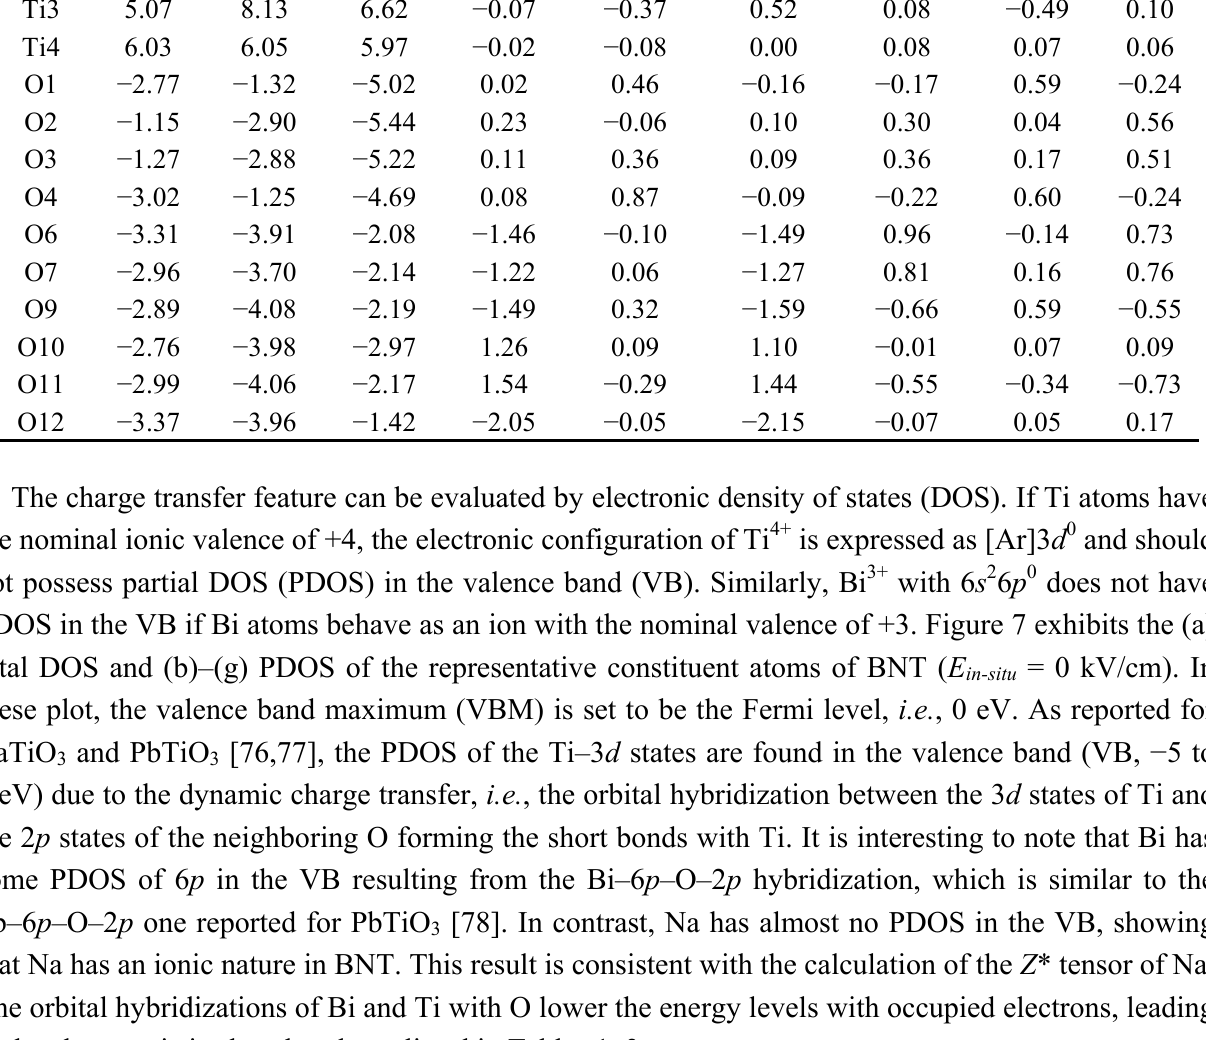
= 0 kV/cm). The elements in in-situ